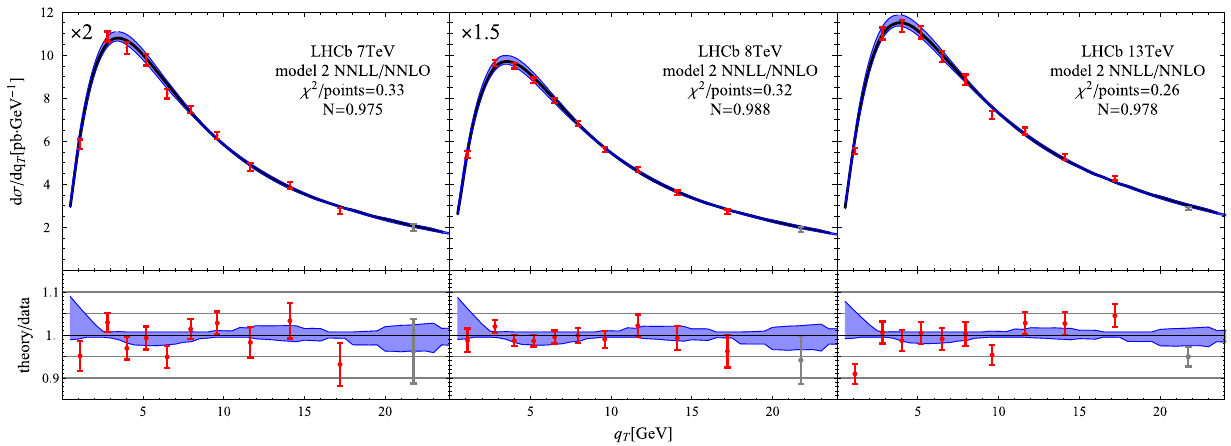
Fig. 12 The comparison of the data for Z-boson production collected at LHCb experiment to the fit of model 2 at NNLL/NNLO. Red data points are those which included in the fit (i.e. with δ T = 0 . 2). Gray data